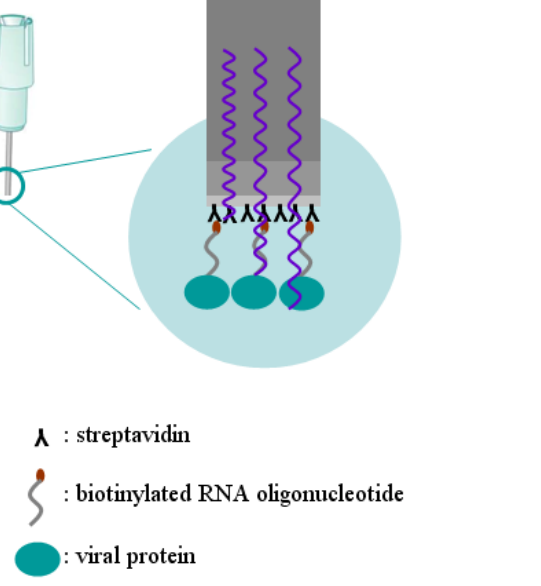
Figure 2. Proprietary new technology for label-free detection. A layer of molecules attached to the tip of an optic fiber creates an interference pattern at the detector with optically coated streptavidin biosensor in solution. Any change in the number of molecules bound causes a measured shift in the pattern, Biolayer Interferometry (BLI) surface chemistry. Relationship of distance between reflecting surfaces and reflected intensity would be investigated. As molecules bind, the spectrum of signal changes as a function of the layer increasing on the